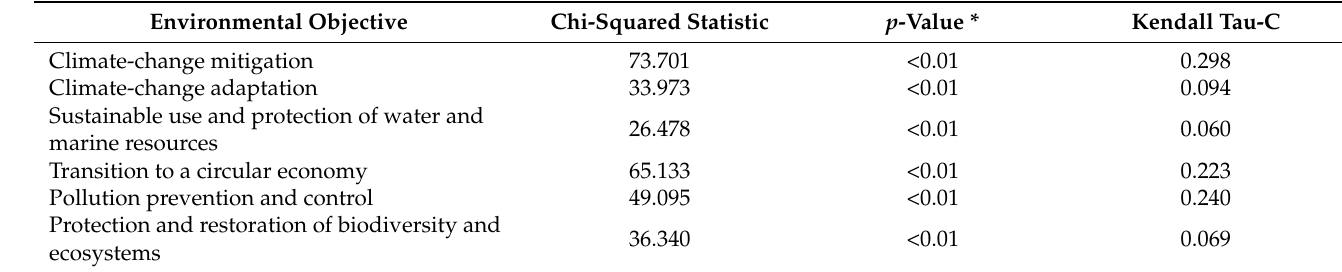
Table 3. Results of the chi-squared test for the relationship between the assessment of the degree of compliance of an enterprise’s activities with environmental objectives and the size of the